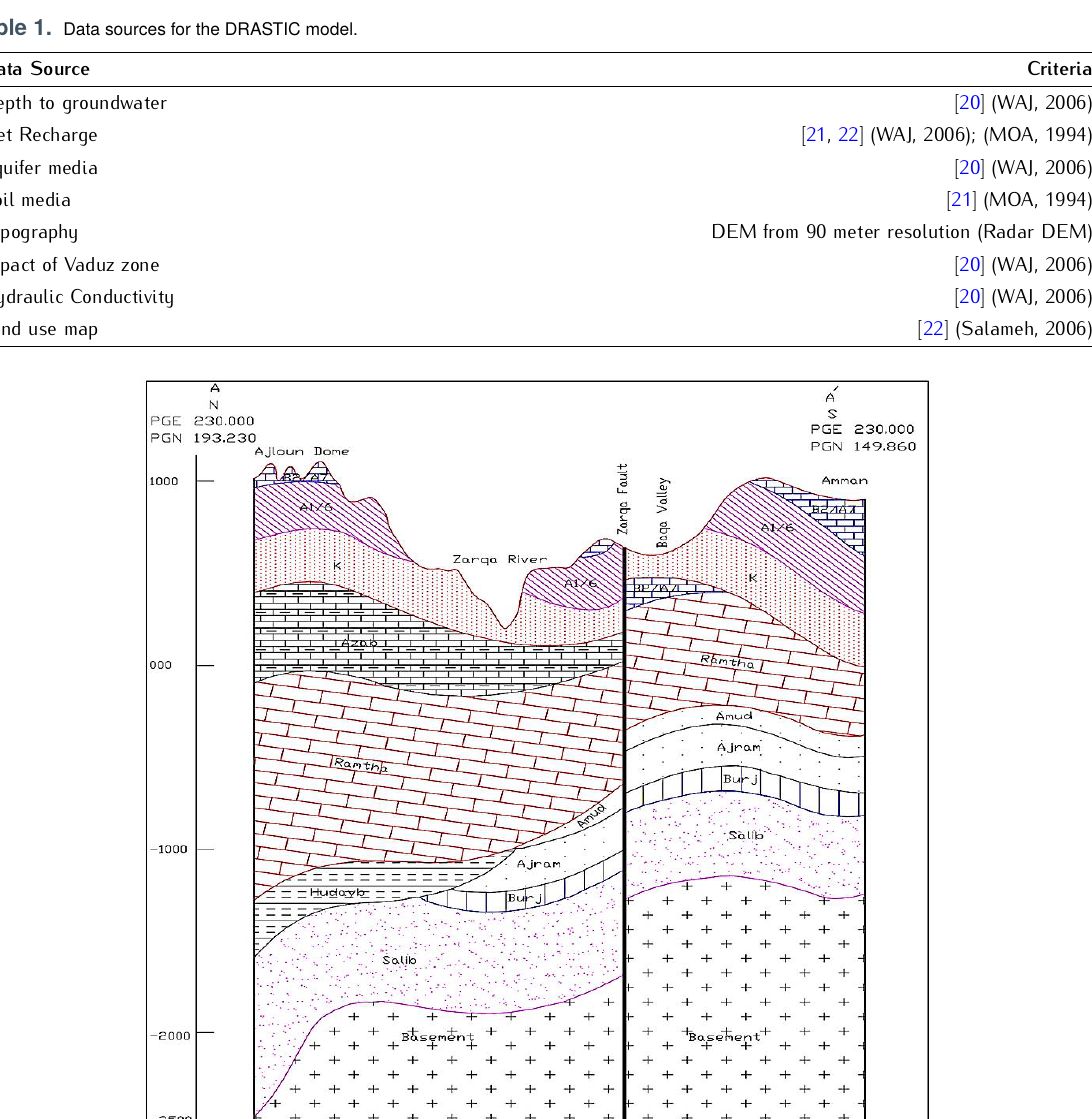
Table 1. Data sources for the DRASTIC model.